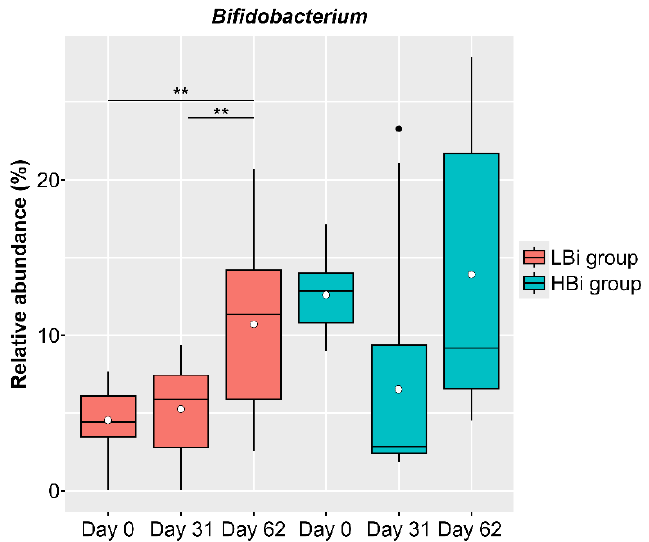
Figure 7. Changes in relative abundance of Bifidobacterium in participants in LBi (low Bifidobacterium ) and HBi (high Bifidobacterium ) groups. Each dot represents outliers. Comparison of the abundance of each genus in the ALDEx2 pipeline showed a significant increase in abundance between Day 0 and 62 and between Day 31 and 62 in the LBi group. ** p < 0.01.